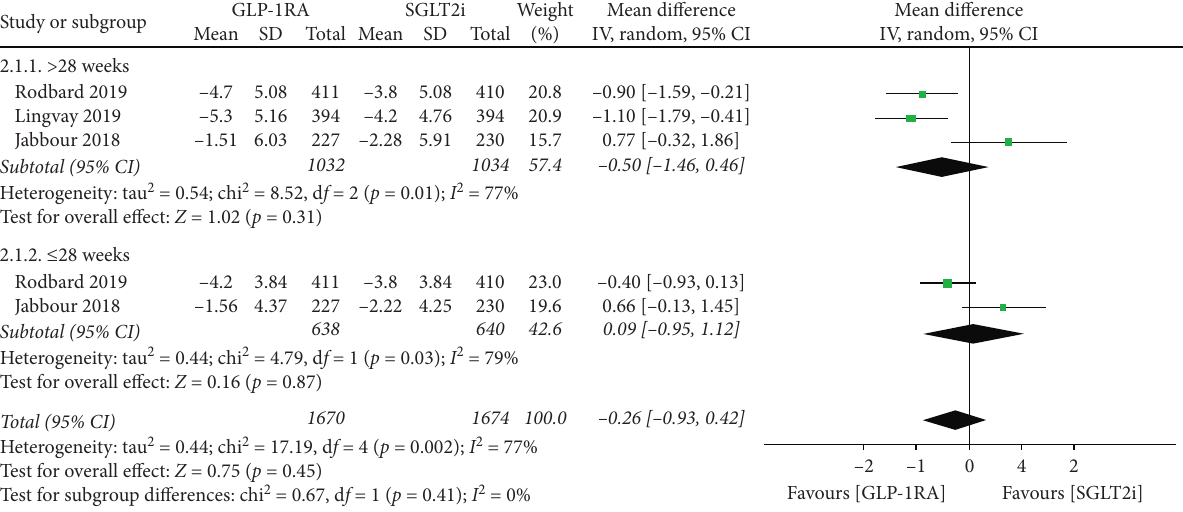
Figure 3: Forest plot for meta-analyses comparing the effect of GLP-1RAs with SGLT-2is in bodyweight. GLP-1RAs: glucagon-like peptide 1 receptor agonists, SGLT-2is: sodium-glucose cotransporter 2 inhibitors, CI: confidence interval, SD: standard deviation.